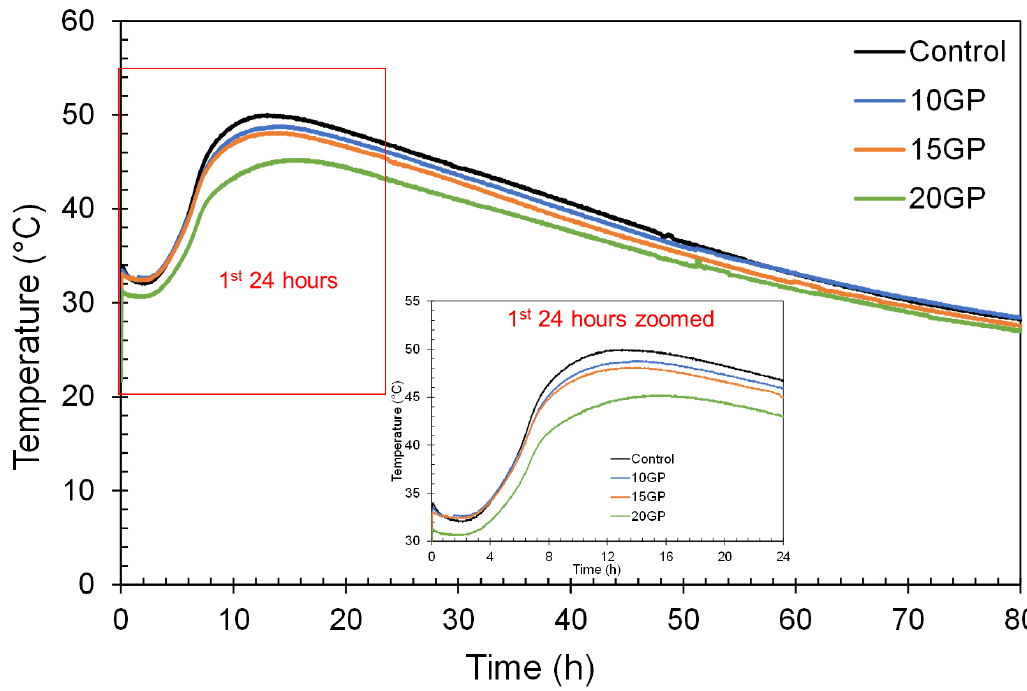
Figure 7. Temperature evolution during hydration of CEM I and GP cements.